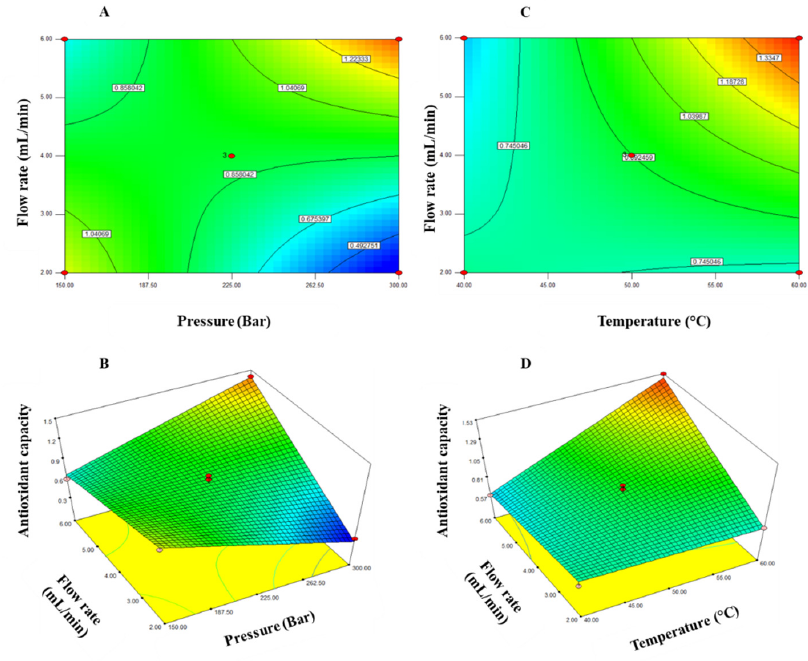
Figure 2. Contour plots ( A ) and response surface ( B ) for the effect of pressure (bar) and flow rate (mL/min) as well as contour plots ( C ) and response surface ( D ) for the effect of temperature (°C) and flow rate (mL/min) on the antioxidant capacity (ABTS assay) of supercritical CO 2 extraction of lyophilized liquor.